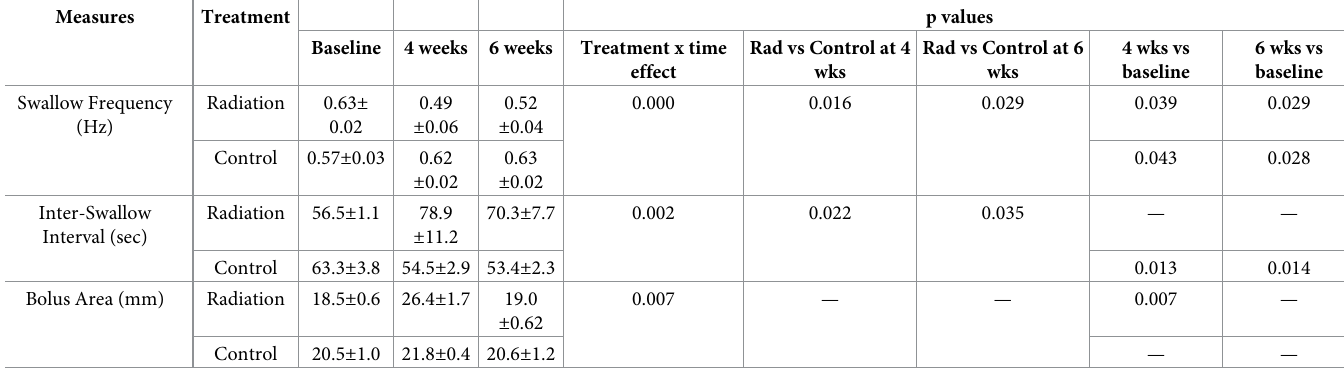
Table 1. Descriptive and statistically significant differences for swallowing